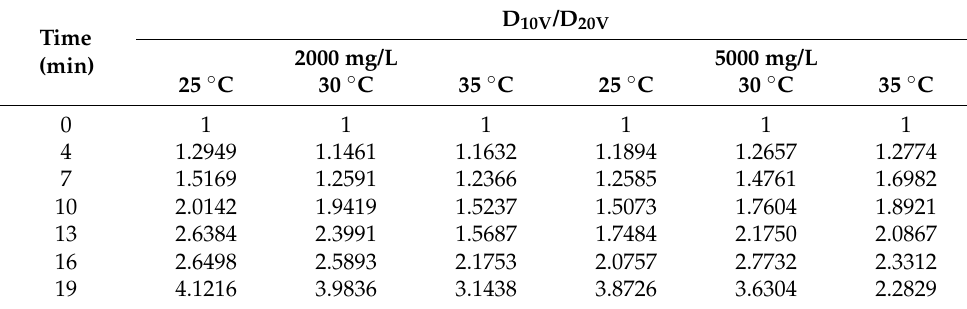
Table 4. Diluate stream concentration ratio between the 10 and 20 V tests.